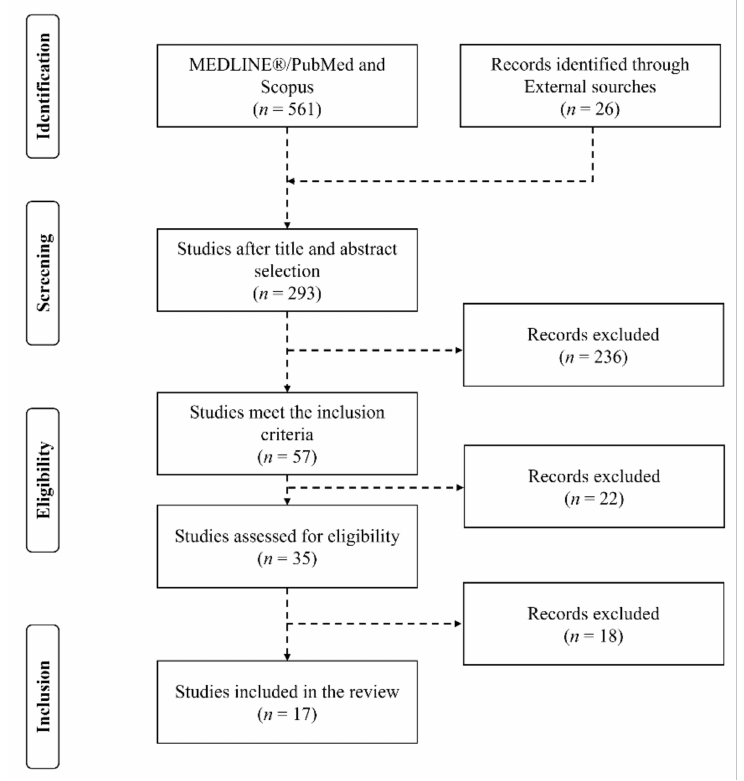
Figure 2. PRISMA flow-diagram.